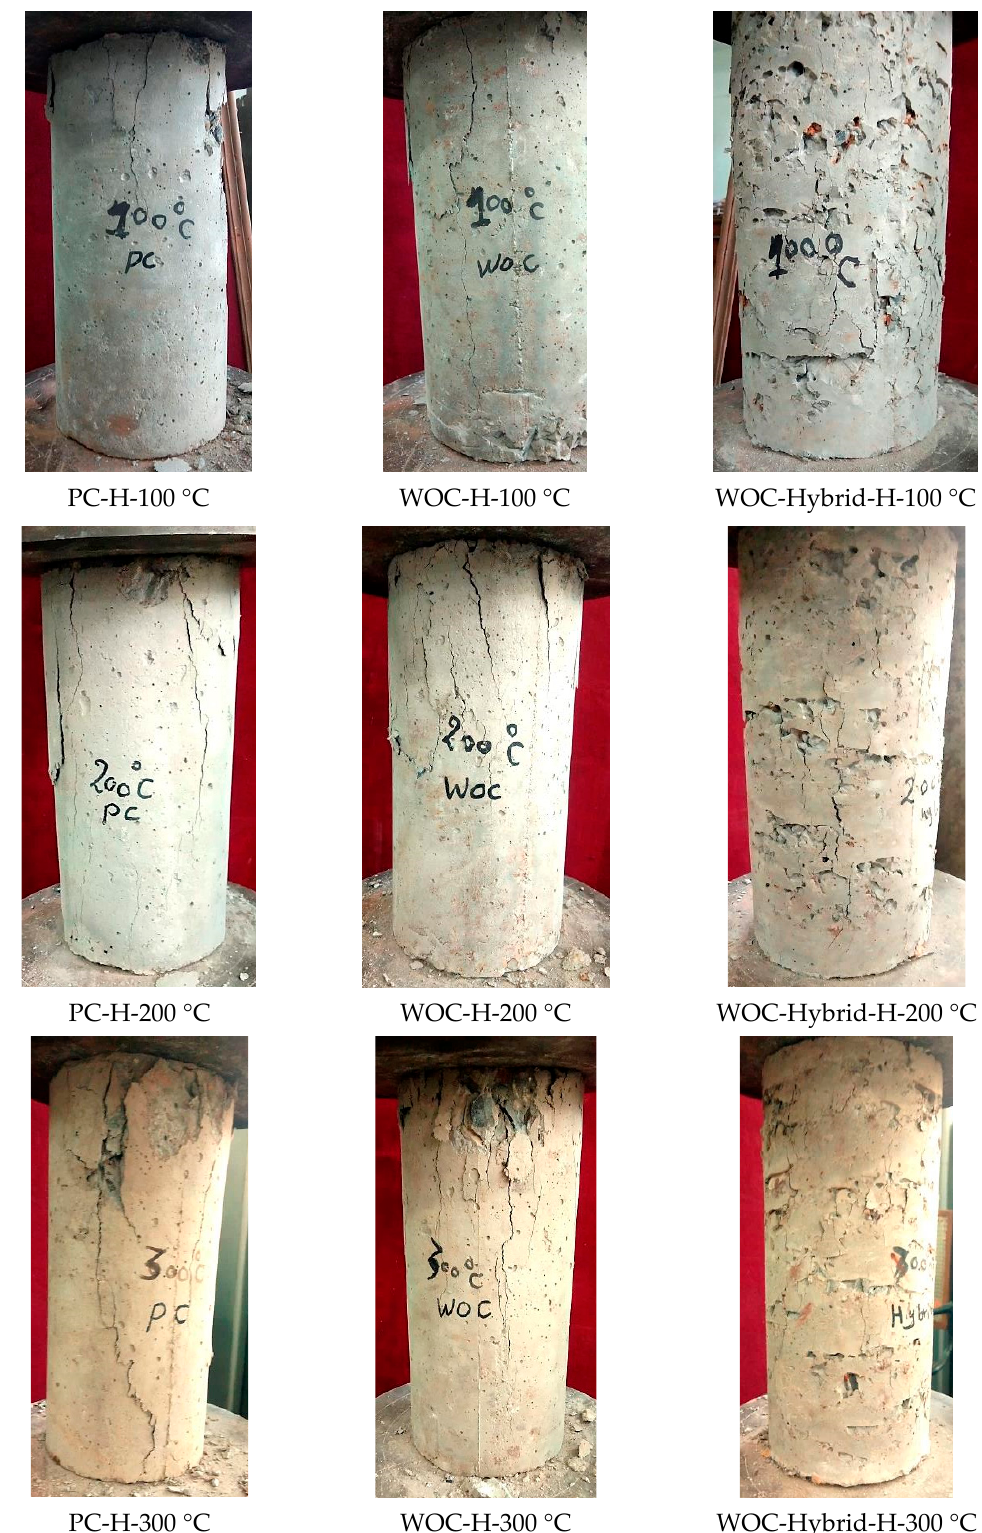
Figure 8. The percentage decrement in compressive strength of PC, WOC, and hybrid specimens at elevated temperatures to samples strength at 25 °C.